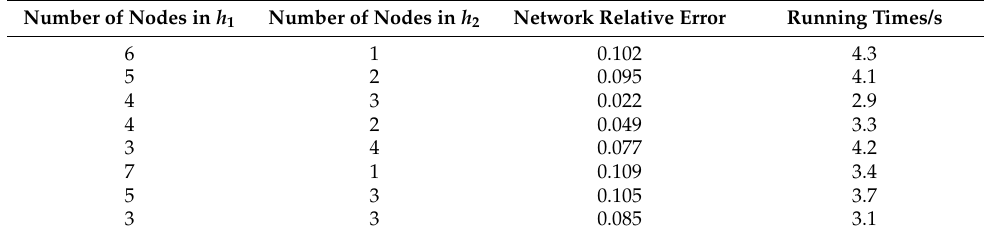
Table 4. Network performance with different number of